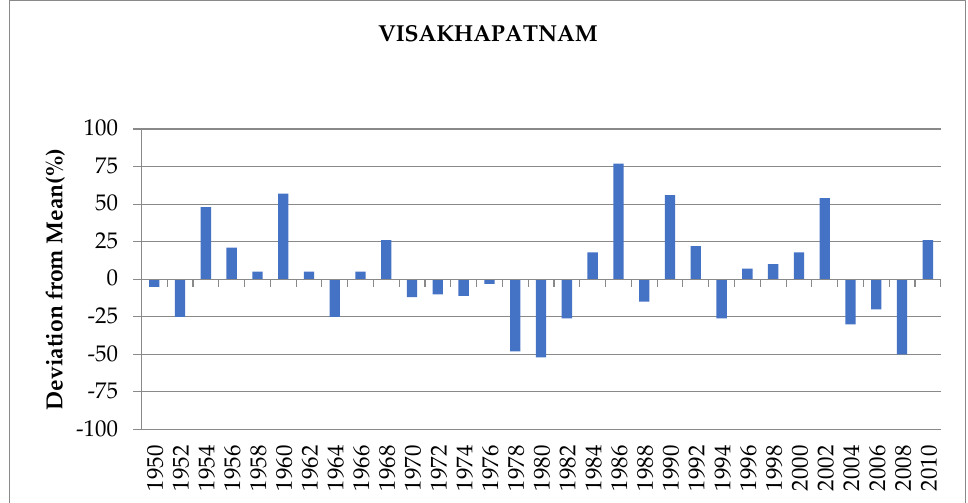
Figure 7. Nominal rainfall over Visakhapatnam district.